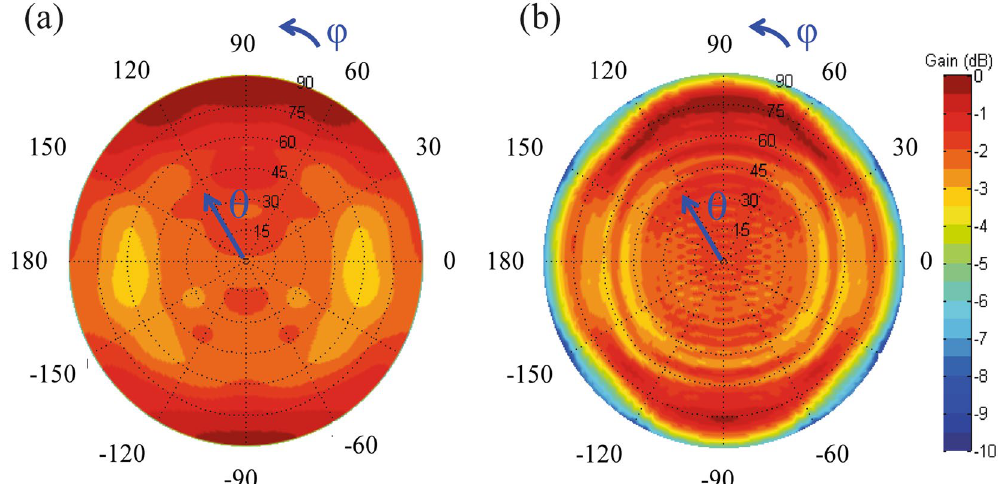
Figure 8. Simulated normalized patterns at 5.8 GHz of the proposed TMC antenna: ( a ) with an infinite ground and ( b ) with a finite ground. The finite ground is a 1200 × 1200 mm 2 rectangular copper